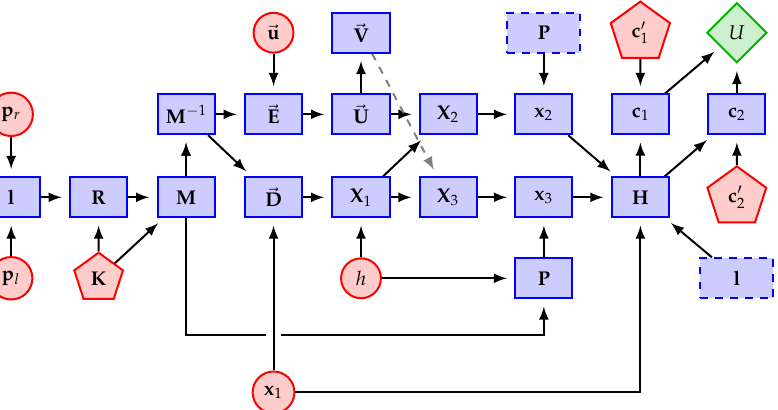
Figure 5. Computational chain for estimating vessel speed (rhombus) using experimental variables with (circles) and without (pentagons)